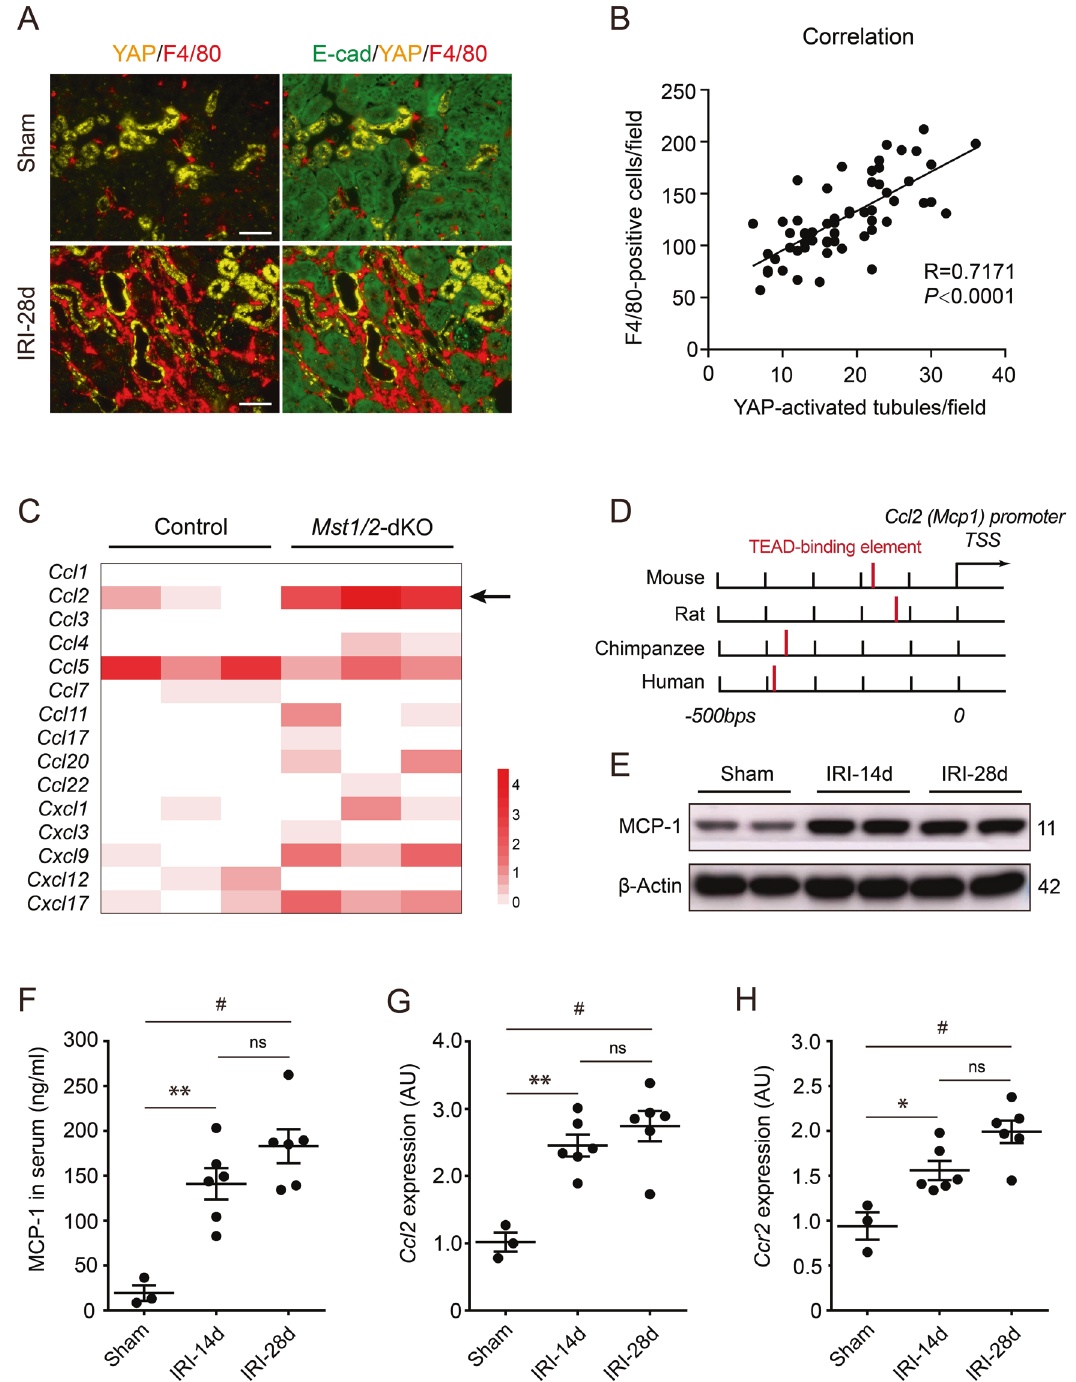
Fig. 3 Tubular epithelial YAP activation associated with macrophage in fi ltration and renal MCP-1 upregulation. A Representative image of double immuno fl uorescent staining with YAP and F4/80 in Sham and IRI-28d kidneys. B YAP-activated tubules and F4/80-positive in fi ltrates were calculated from 55 randomly captured images at IRI-28d kidneys. Correlation between YAP-activated tubules and F4/80-positive in fi ltrates was analyzed ( n = 55). Pearson correlation R value and P value are indicated. C Gene expression analysis for chemokine members including CCL and CXCL family in Mst1/2 knockout mice. Gene Expression Omnibus (GEO) datasets supply the RNA-sequencing data of GES95463. D Regulatory elements of the genes encoding MCP-1 from various mammals were reported by Kim et al.[20]. The TEAD-binding element (red bar) is located 100 – 400 bp upstream of the transcription start site of MCP-1. TSS transcription start site. E Representative western blot analysis of MCP-1 protein expression in kidney lysates from mice 14 and 28 days after IRI ( n = 6 mice per group). Sham-operated mice was used as a control ( n = 3 mice). F ELISA analysis of MCP-1 levels in serum. G , H Quantitative polymerase chain reaction analysis of MCP-1 ( Ccl2 ) and CCR2 ( Ccr2 ) mRNA expression in kidneys. AU arbitrary units. Scale bar = 50 µm in all images of A . All values are means ± SEM. *p < 0.05 , **p < 0.01, and # p < 0.001 de fi ned as signi fi cant. ns not signi fi